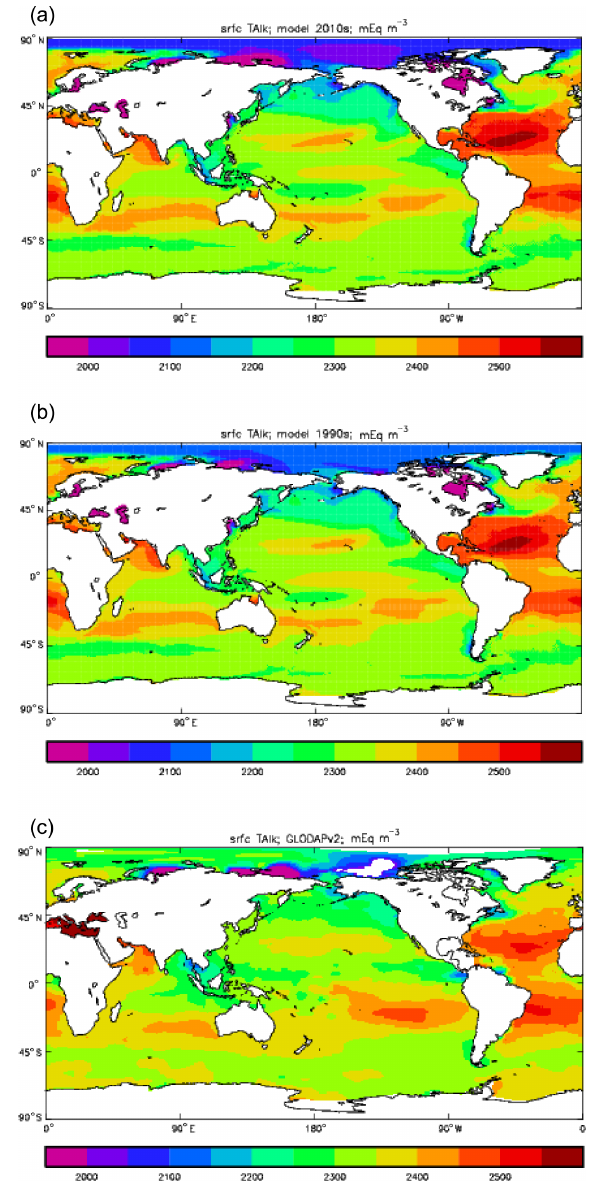
Figure 12. Surface concentration of total alkalinity (mEqm − 3 ): (a) model field averaged over model years 2010–2019; (b) model field averaged over model years 1990–1999; (c) the gridded field from the GLODAPv2